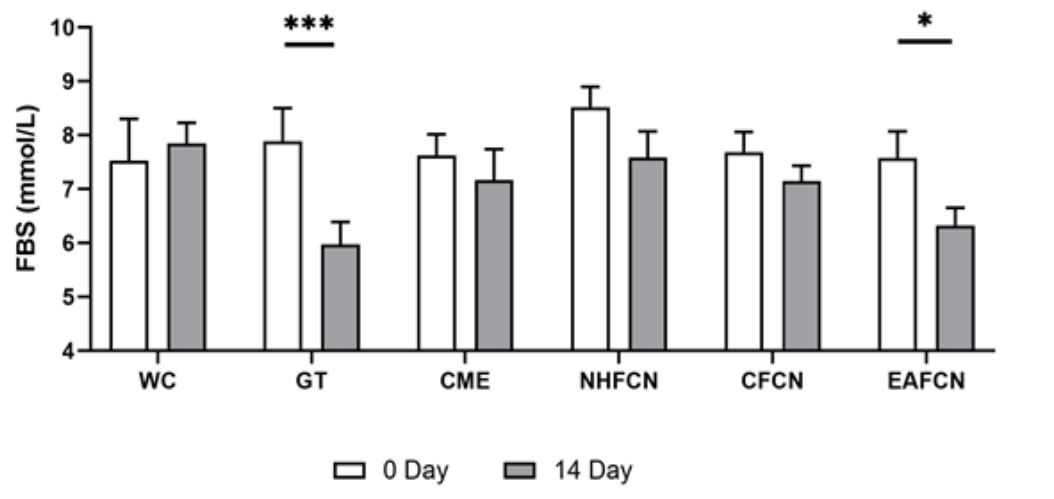
Fig. 1. Chronic hypoglycemic effects of cocos nucifera extracts. Serum blood glucose was measured at 0 day and after treatment for 14 days. Results are expressed as mean ± SD. WC, Water control; GT, Glibenclamide treatment; CME, crude methanolic extract; NHFCN, n-hexane fraction; CFCN, Chloroform fraction; EAFCN, Ethyl acetate fraction. Analysis was performed within groups using paired 't-tests (*p<0.05,